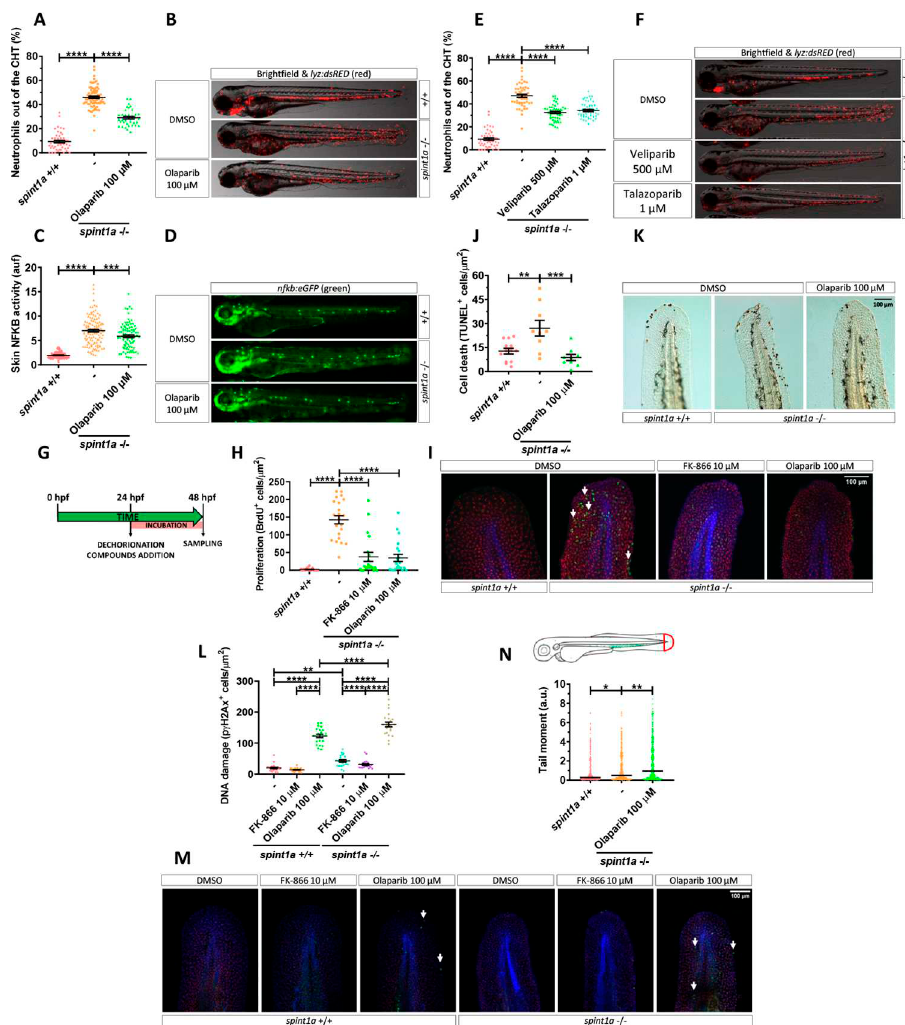
Fig 4. Pharmacological inhibition of Nampt and Parp1 alleviates skin oxidative stress and inflammation and keratinocyte cell death, hyperproliferation and DNA damage in Spint1a-deficient larvae. Analysis of neutrophil distribution (A, E) and NFKB transcriptional activity in the skin (C) of wild-type and Spint1a-deficient larvae treated with olaparib (A, C) , and veliparib or talazoparib (E) . Representative images (brightfield and red channel in B, F; green channel in D) of lyz : dsRED and nfkb : eGFP zebrafish larvae of every group are shown. Determination of BrdU positive cells from 48 hpf wild-type and Spint1a-deficient zebrafish larvae treated for 24 hours with 10 μ M FK-866 or 100 μ M olaparib (G, H) . Representative merge images maximum intensity projection of a confocal Z stack from zebrafish larvae of every group are shown (I) . WIHC with anti-BrdU (green, arrows), anti-p63 (red, basal keratinocyte marker) were counterstained with DAPI (blue). Quantification of TUNEL positive cells from 48 hpf wild-type and Spint1a- deficient zebrafish larvae treated for 24 hours with 100 μ M olaparib (J) . Representative images of zebrafish larvae of every group are shown (K) . Quantification of p γ H2Ax positive cells from 48 hpf wild-type and Spint1a-deficient zebrafish larvae treated for 24 hours with 10 μ M FK-866 or 100 μ M olaparib (L) . Similarly, around 60 zebrafish tail folds (red boxed area) were amputated and disaggregated into cells for comet assay analysis in alkaline conditions (N) . Representative merge images of maximum intensity projection of an apotome Z stack from zebrafish larvae of every group are shown (M) . WIHC with anti-p γ H2Ax (green, arrows), anti-P63 (basal keratinocyte marker, red) were counterstained with DAPI (blue). Scale bars, 100 μ m. Each dot represents one individual. The mean ± SEM (A-L) and median (N) for each group is shown. p -Values were calculated using 1-way ANOVA and Tukey multiple range test (A-L) and Kruskal–Wallis test and Dunn multiple comparisons test (N). � p � 0.05, �� p � 0.01, ��� p � 0.001, ���� p � 0.0001. The data underlying this figure can be found in S1 Data. ANOVA, analysis of variance; Nampt, nicotinamide phosphoribosyltransferase; Parp1, Poly(ADP-Ribose) polymerase 1; TUNEL, terminal deoxynucleotidyl transferase dUTP nick end